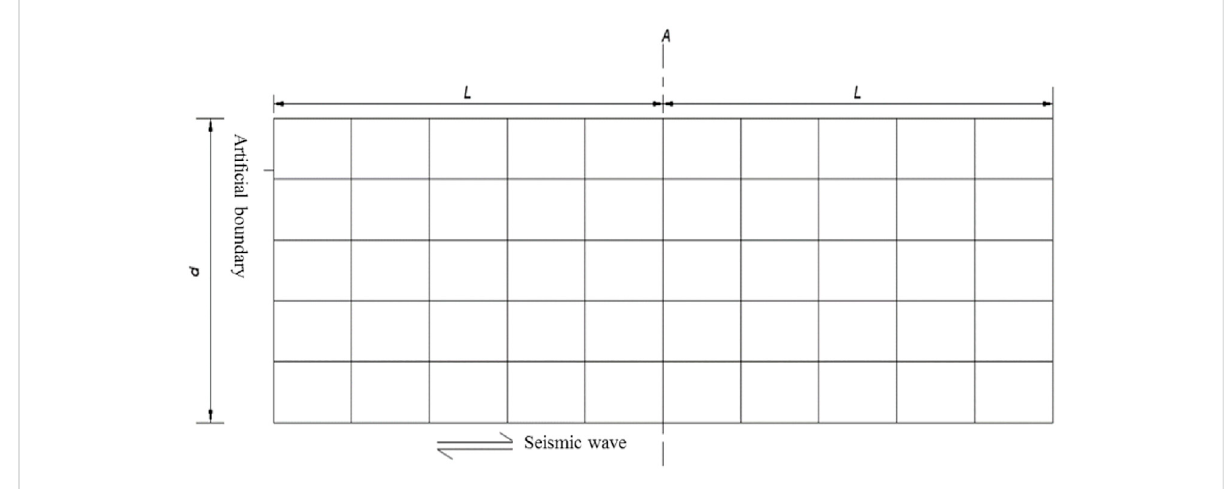
FIGURE 7 Schematic diagram of the fi nite-element calculation model of the soil